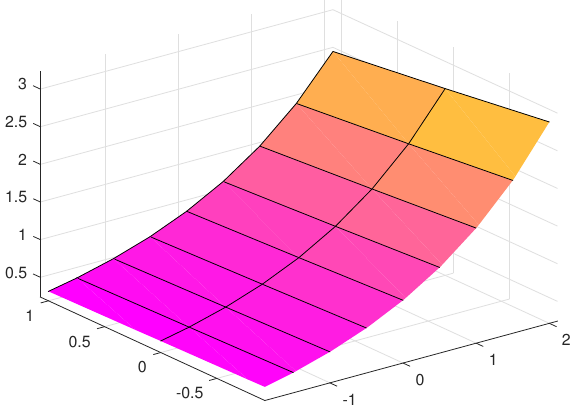
Figure 4. Comparison between approximate solution by SDM and VITM plot of example 1 at γ =